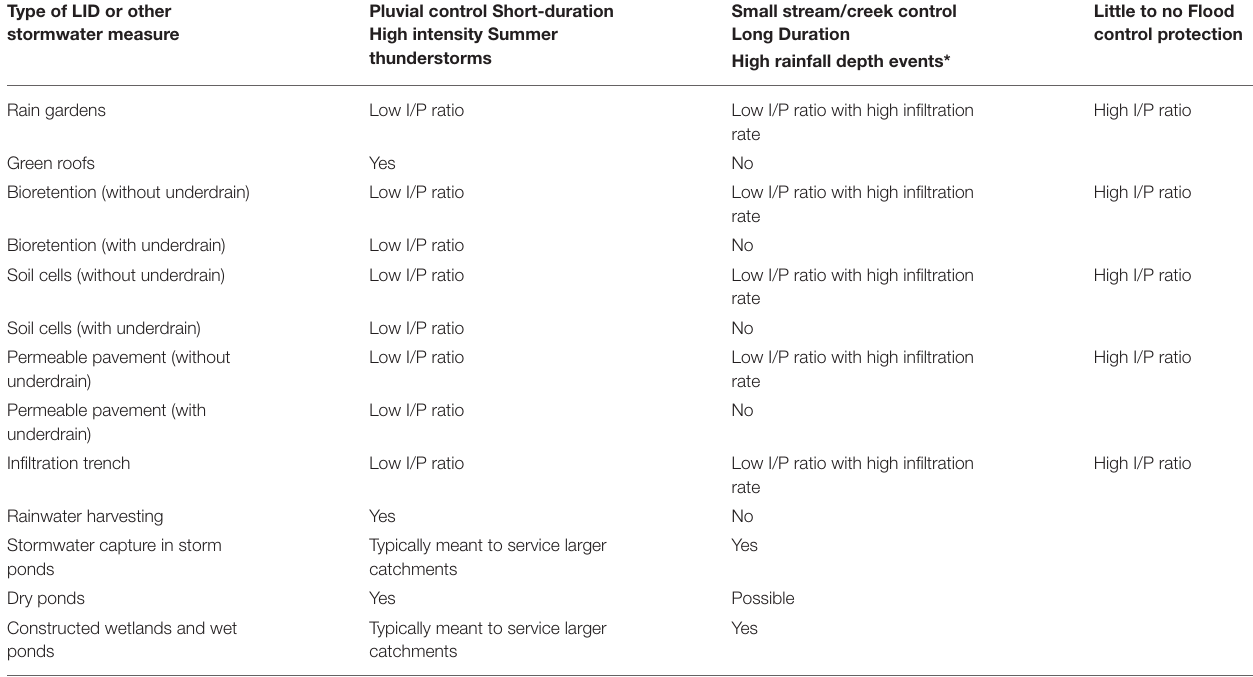
TABLE 3 | Range of applicability of LID and other measures for flood